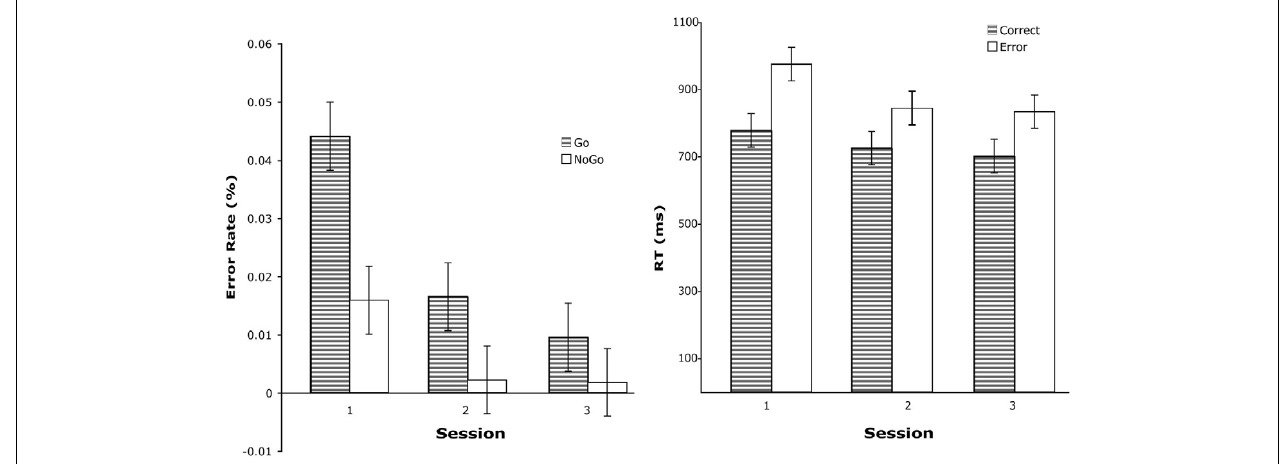
FIGURE 2 | Left: error rate for stimulus type and practice session. Error rates are for post-learned trials. Right: mean RT for practice session and accuracy.